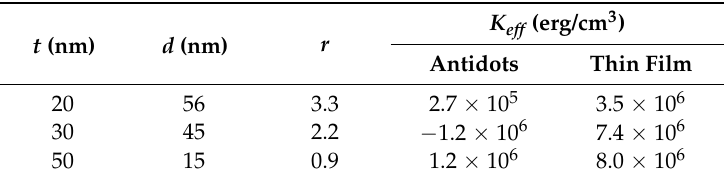
Table 1. Effective INP anisotropy constants, K eff , for Dy 13 Fe 87 thin films and antidot arrays with different thicknesses ( t ), antidot hole diameters ( d ) and antidot aspect ratios ( r